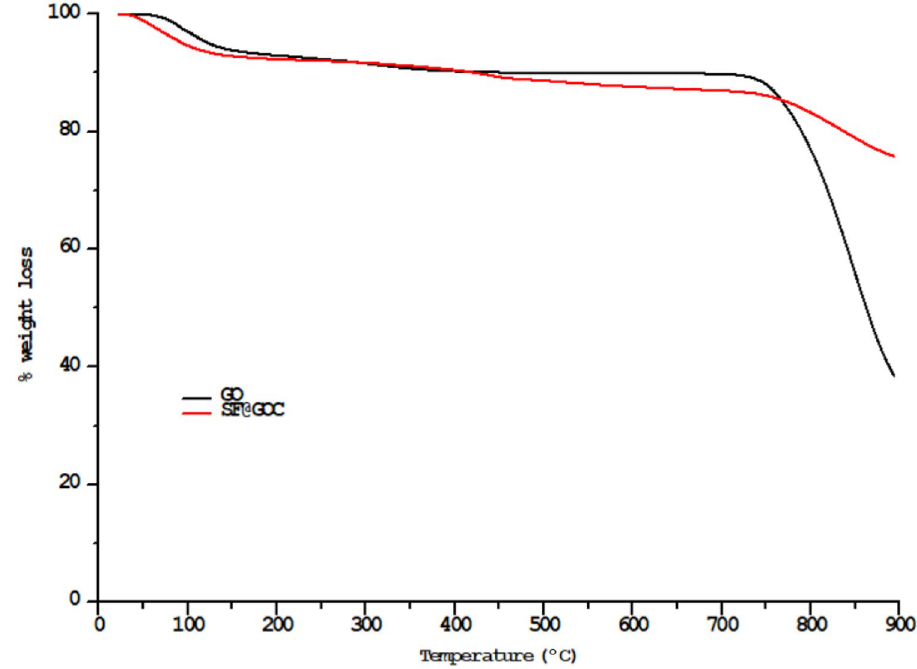
Figure 5. TGA curves of GO and SF@GOC .